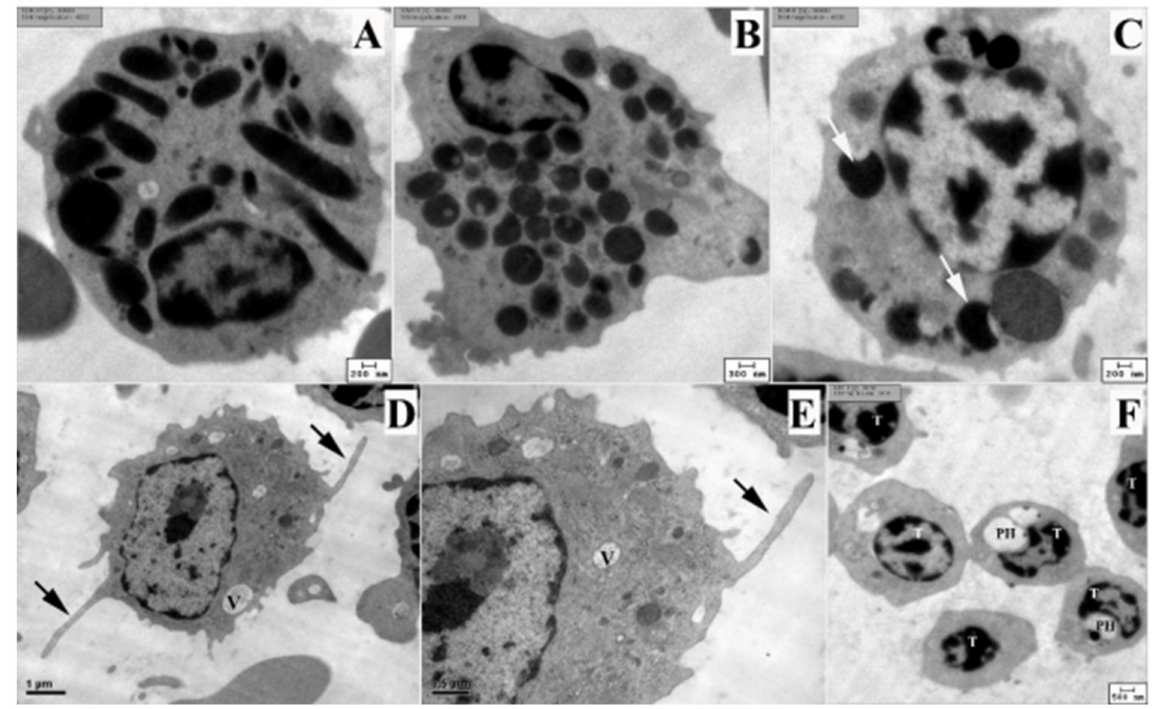
Figure 3. Transmission electron micrographs of blood cells in rufous-winged buzzards. Het- erophil ( A ), eosinophil ( B ), basophil ( C ), monocytes ( D – E ), and six thrombocytes ( F ). Basophil shows two types of granules: heterogeneous electron dense granules and homogeneous electron dense granules (white arrows). Monocytes show the long cytoplasmic processes (back arrows) and cytoplasmic vacuoles (V). High magnification of mitochondria and rough endoplasmic reticulum ( E ). Some of thrombocytes (T) shows the perinuclear halo (PH). Uranyl acetate and lead citrate stains. The electron micrographs were taken by the HT770 TEM ( A – C , F ) and JEM1230 TEM ( D–E